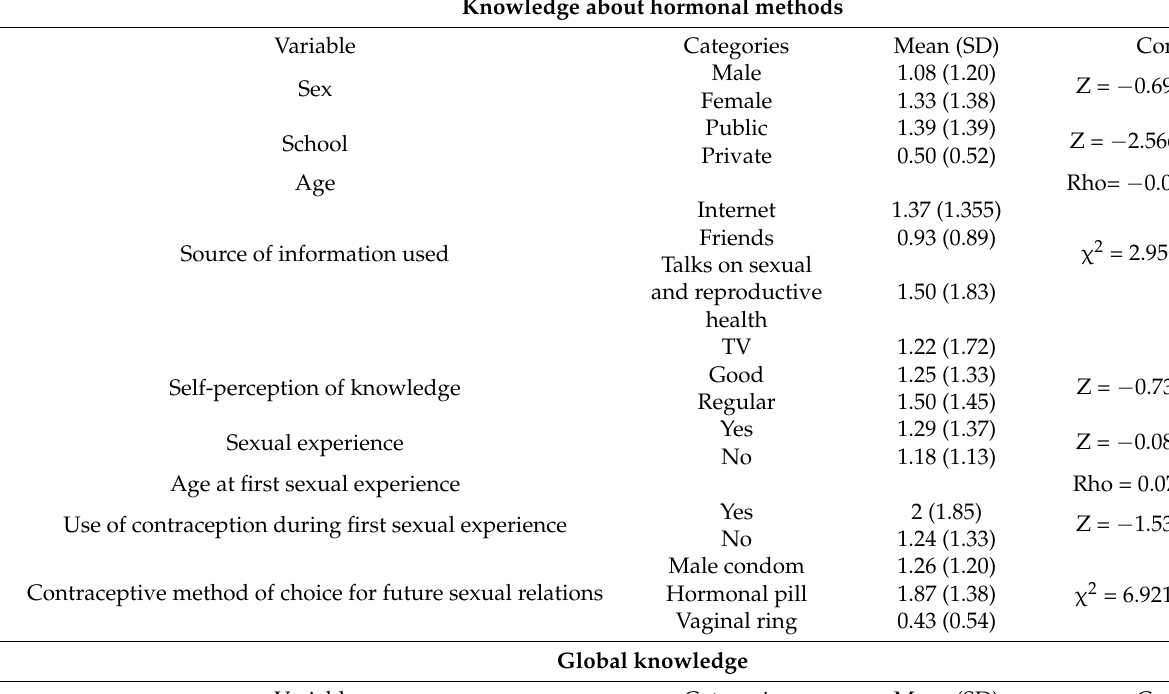
Table 2. Cont . Knowledge about hormonal